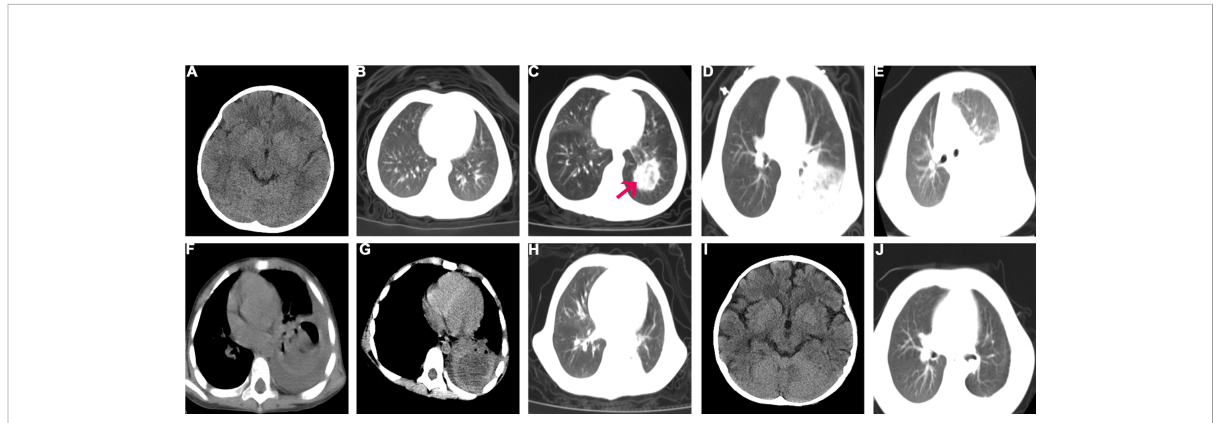
FIGURE 1 Brain and Chest CT before and after surgery. (A) Brain CT before chemotherapy; (B) Chest CT before chemotherapy; (C) Day 30, a nodular lesion (3.2 cm × 2.8 cm, red arrow) in the post-basal segment of the left lower lobe with ground glass opaci fi cation; (D) Day 38, the initial nodular lesion was larger, and new lesion in the upper lobe of the right lung; (E, F) . Day 52, the initial nodular lesion was 4.7 cm × 24.3 cm with part consolidation and the balloon cavity; the initial regional hazy shadow was spread diffusely in the left lung. (G) No regression of lesions and fungal fl ora in blood vessel on CTA (I) Brain CT on 6 months after surgery; (J) Chest CT on 6 months after lung lobectomy, no progression of